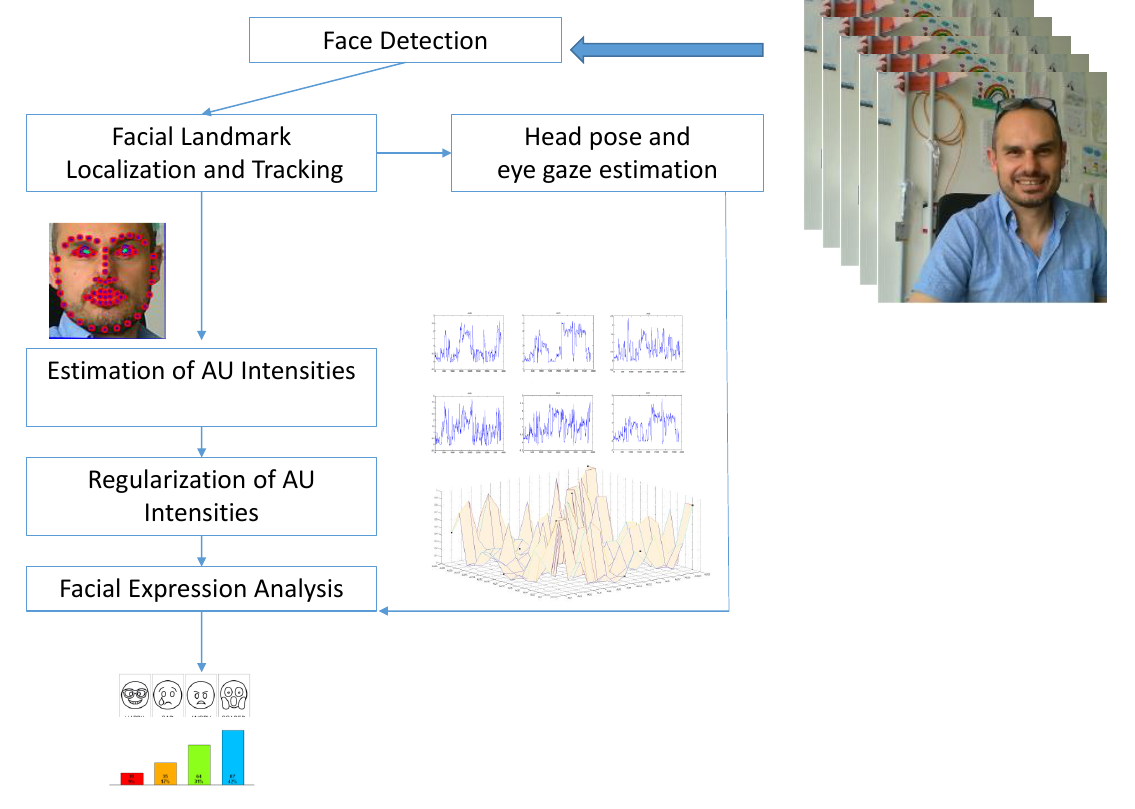
Figure 1. The algorithmic